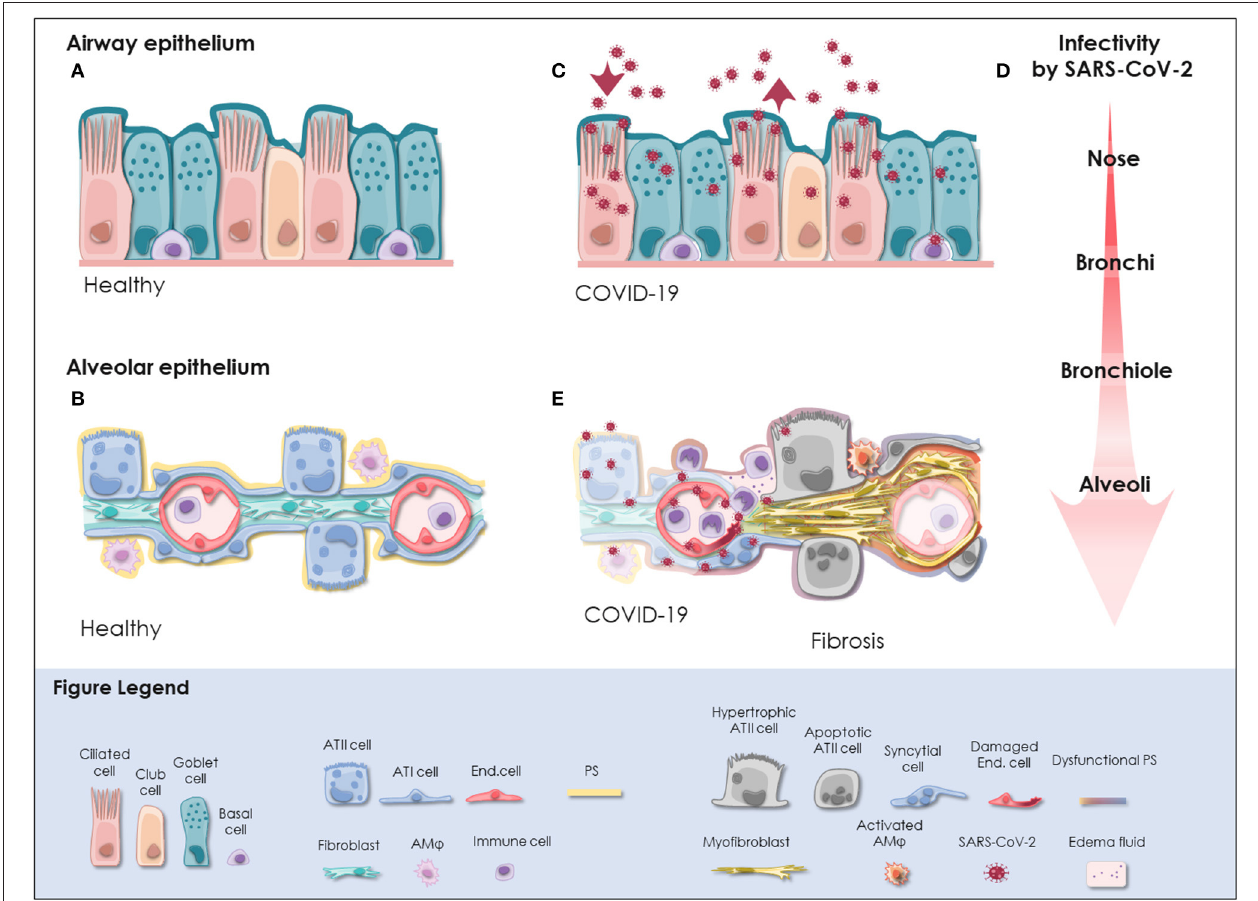
FIGURE 1 | SARS-CoV-2 infection in the respiratory tract. (A) In the pseudostratified epithelium of the airways, secretory goblet, and club cells produce mucus, which is transported by ciliated cells to clear trapped particles and protect the lung from micro-injuries and infection. Basal cells reside at the lamina propria and comprise progenitor cells. The composition and frequency of the individual cell types is variable among the distinct anatomical sites in the nose, trachea, bronchi, and bronchioles. (B) The alveolar epithelium is specialized for gas exchange with flattened ATI cells forming an ultra-thin ( ∼ 2 µ m) epithelial-endothelial barrier allowing oxygen and CO 2 diffusion. Cuboidal ATII cells are considered as progenitor cells of ATI cells and fulfill vital functions by the production of pulmonary surfactant (PS), which lowers surface tension and prevents alveolar collapse. Lung fibroblasts are essential to maintain the ATII stem cell niche. Resident alveolar macrophages (AM ϕ ) and immune cells defend the epithelium from infection. (C) SARS-CoV-2 initially infects the airway epithelium. The virus can efficiently replicate in ciliated and secretory cells resulting in the shedding of high viral titers and mild to moderate COVID-19 symptoms. (D) The respiratory epithelium exhibits differential susceptibility to SARS-CoV-2 infection. In correlation with ACE2 expression, SARS-CoV-2 infection is most efficient in the upper airways, particularly in the nasal epithelium. Infectivity gradually decreases toward the alveoli. However, when SARS-CoV-2 reaches the alveoli it can result in severe manifestation of COVID-19. (E) Upon reaching the alveoli, SARS-CoV-2 infects alveolar epithelial cells and endothelial cells and causes viral pneumonia. Cytopathic effects of SARS-CoV-2 are evident as syncytial and apoptotic alveolar epithelial cells resulting in the breakdown of pulmonary surfactant and barrier integrity. In some patients, alveolar damage culminates in life-threatening microvascular activation and an imbalanced immune response. Tissue regeneration takes place already during acute COVID-19 as indicated by fibrin deposition, ATII cell hyperplasia and alveolar wall thickening. Moreover, severely ill COVID-19 patients exhibit radiological signs of fibrosis even months after recovery indicative for the induction of COVID-19-associated fibrosis. ACE2, angiotensin-converting enzyme 2; ATI cell, type I alveolar epithelial cell; ATII cell, type II alveolar epithelial cell; COVID-19, coronavirus disease 2019; End. cell, endothelial cell; AM ϕ , alveolar macrophage; PS, pulmonary surfactant; SARS-CoV-2, severe acute respiratory syndrome coronavirus